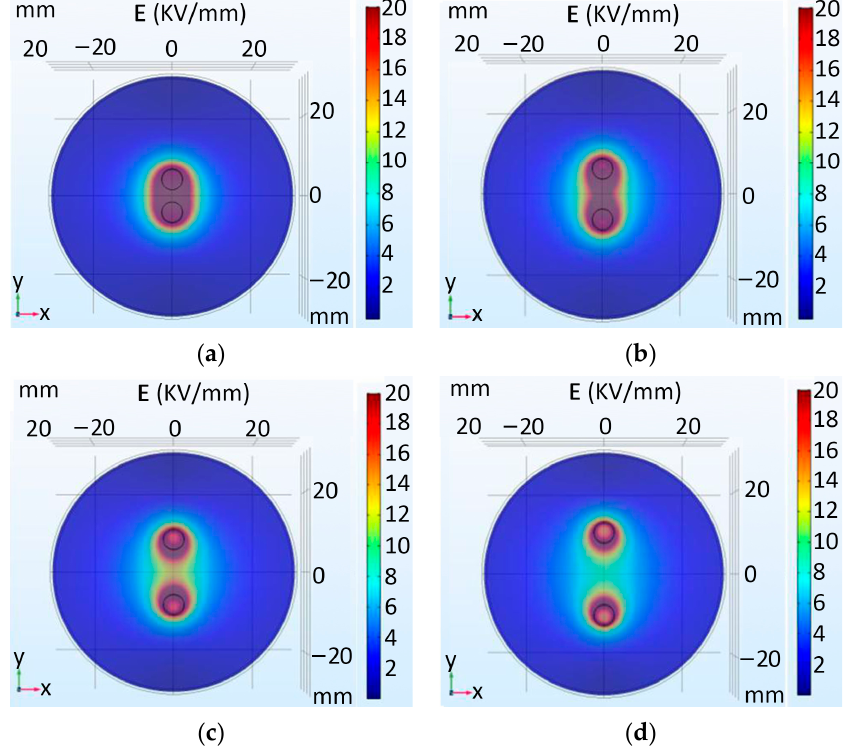
Figure 15. EFS distribution of rock with different electrode spacing. ( a ) EFS distribution (8 mm); ( b ) EFS distribution (12 mm); ( c ) EFS distribution (16 mm); ( d ) EFS distribution (20 mm).